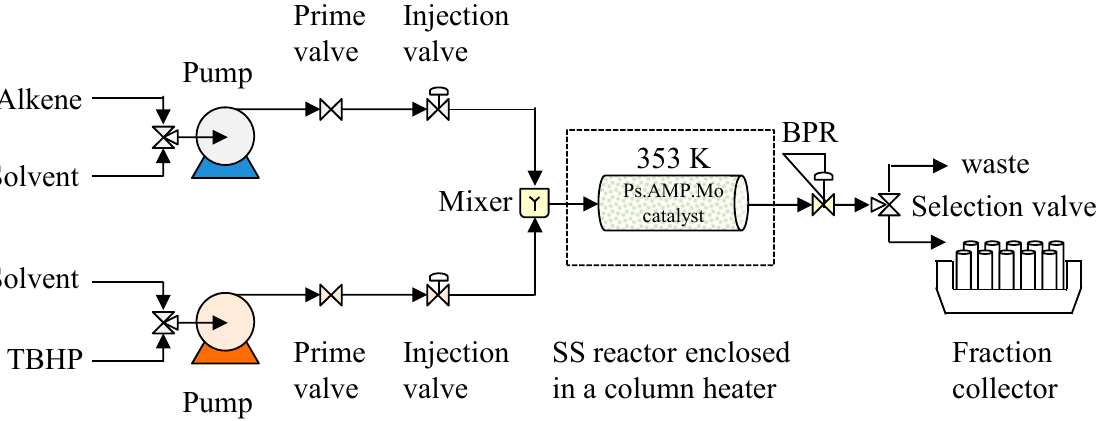
Figure 1. Schematic representation of continuous epoxidation of 4-vinyl-1-cyclohexene with TBHP using a FlowSyn reactor.